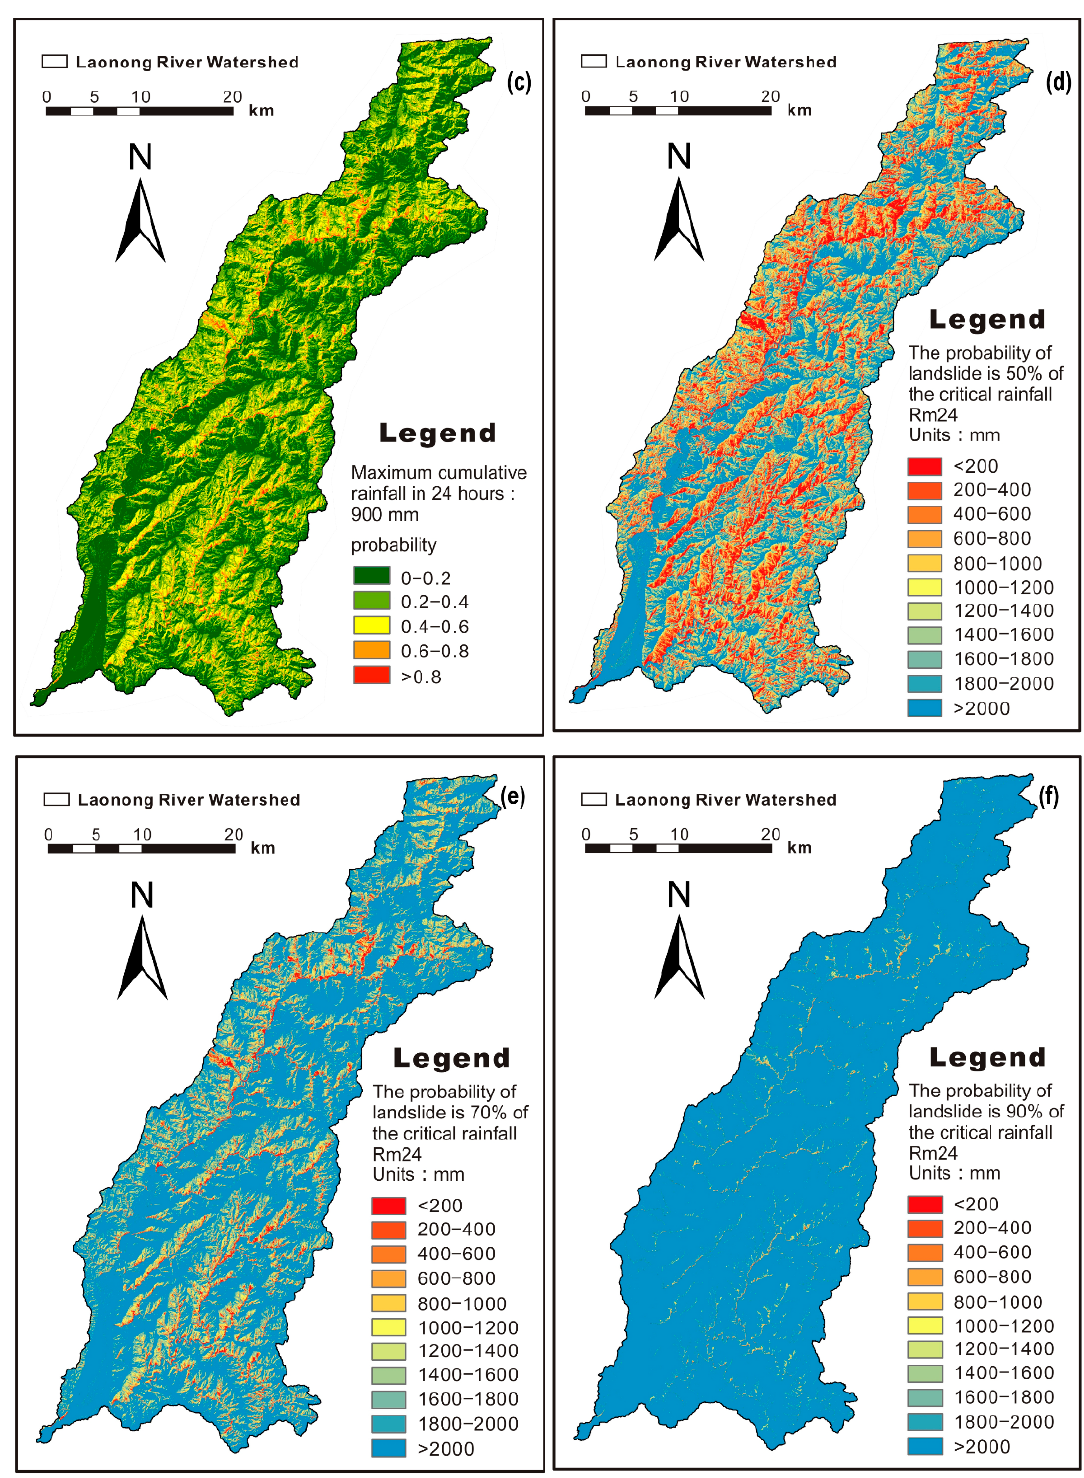
Figure 8. Simulation results of landslide probability due to rainfall and critical rainfall derived from the mixed model. ( a ) rainfall of 300 mm, ( b ) rainfall of 600 mm, ( c ) rainfall of 900 mm, ( d ) landslide probability of 50%, ( e ) landslide probability of 70%, ( f ) landslide probability of 90%.